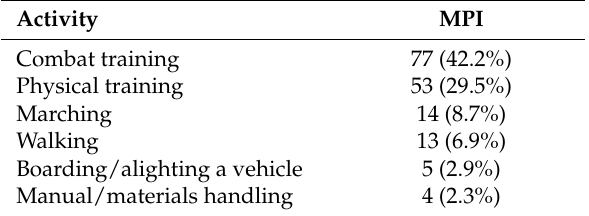
Table 3. The activity in which soft tissue injuries occurred at the knee in part-time personnel. Activity